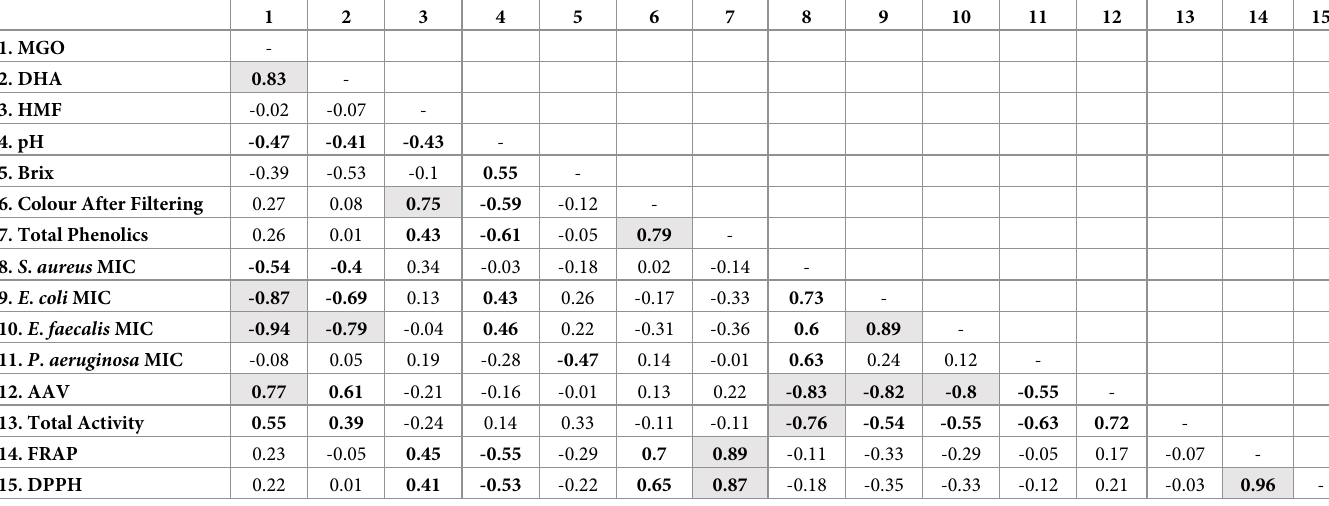
Table 3. Pearson correlation matrix showing relationships between physicochemical properties, antibacterial and antioxidant activities of manuka/ Leptospermum